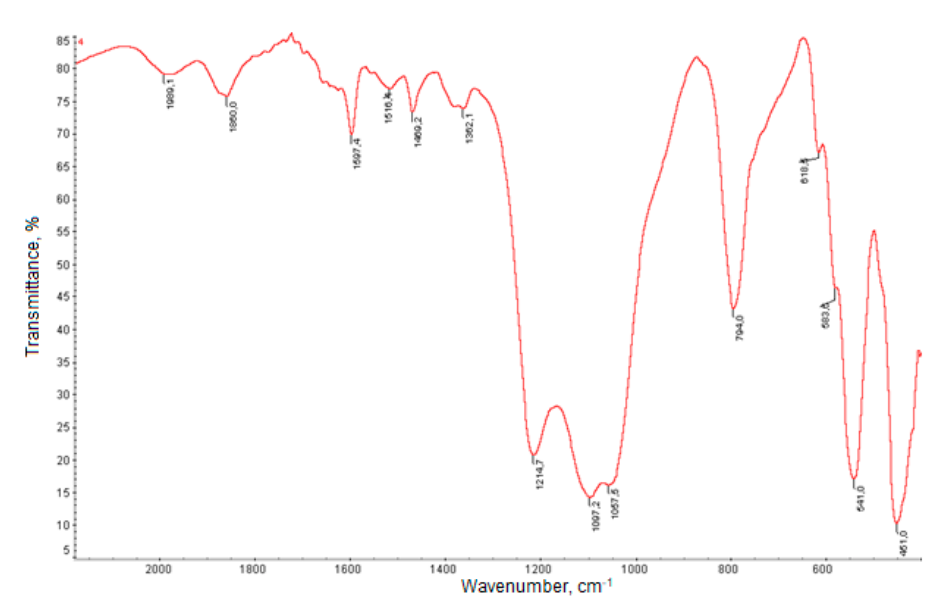
Figure 2. IR spectrum of H ‐ ZKE ‐ AF zeolite catalyst.